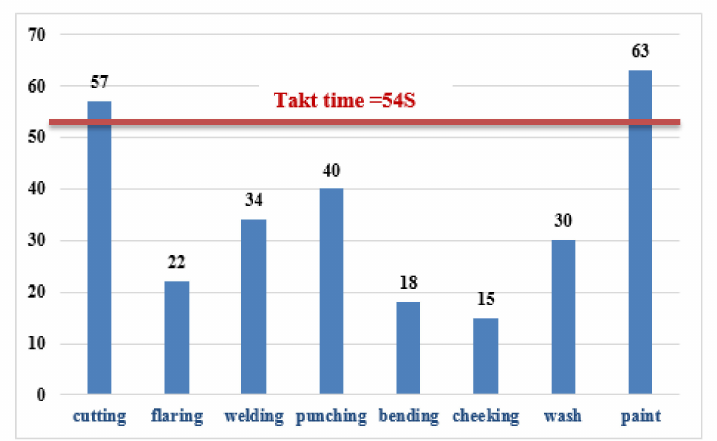
Figure 4. Cycle time of each satellite dish kit (before improvement; units: second).